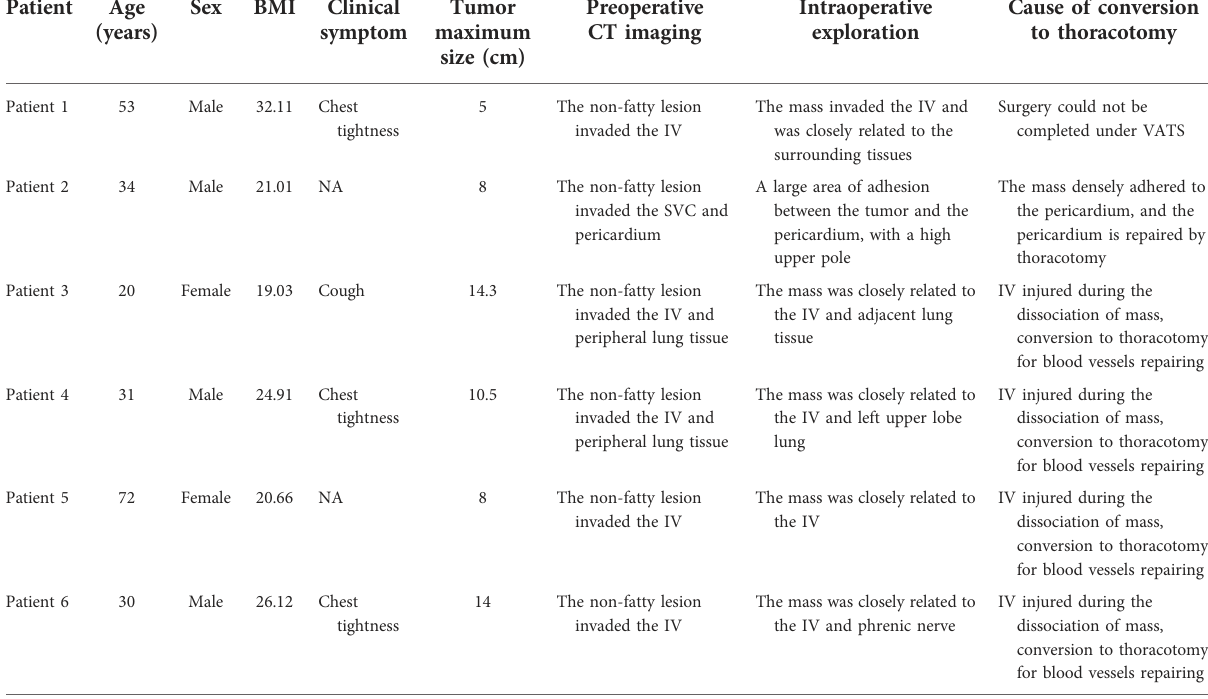
TABLE 3 Details of patients converted to